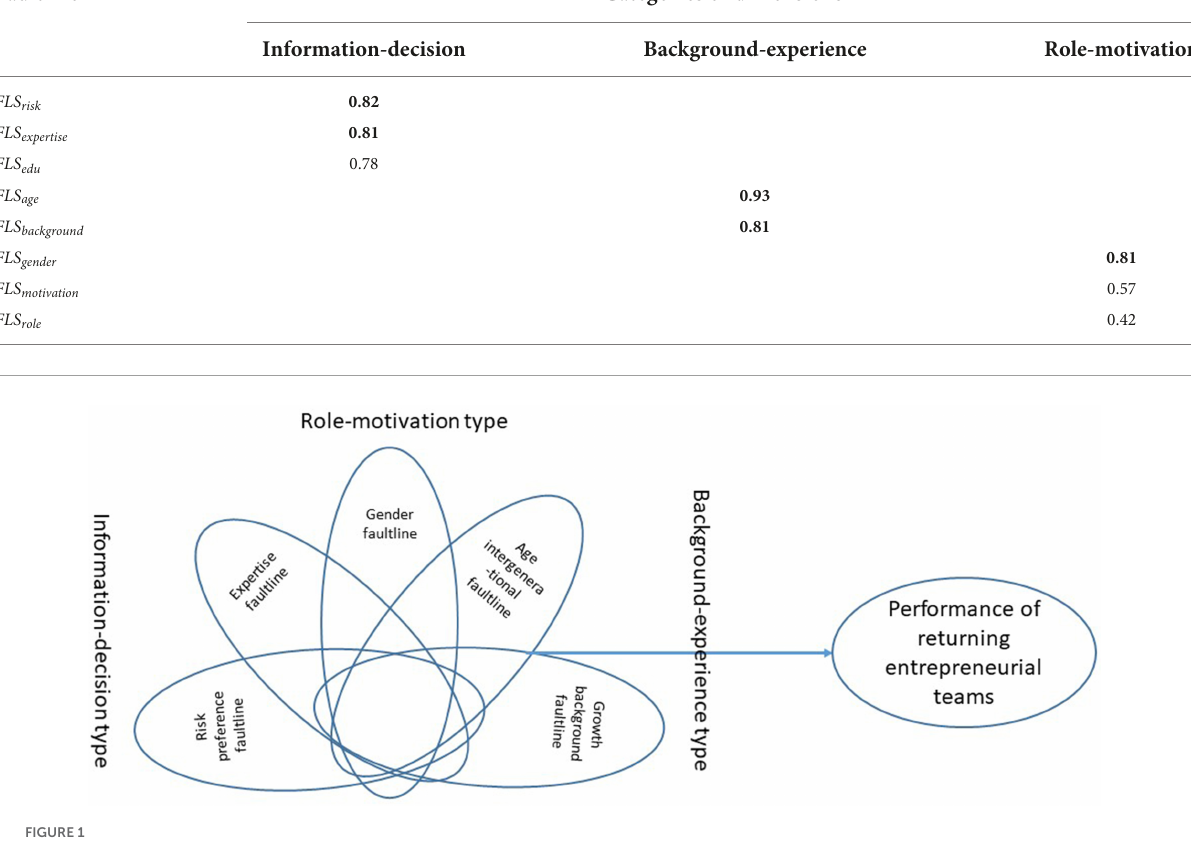
TABLE 3 Principal component factor coefficient matrix.